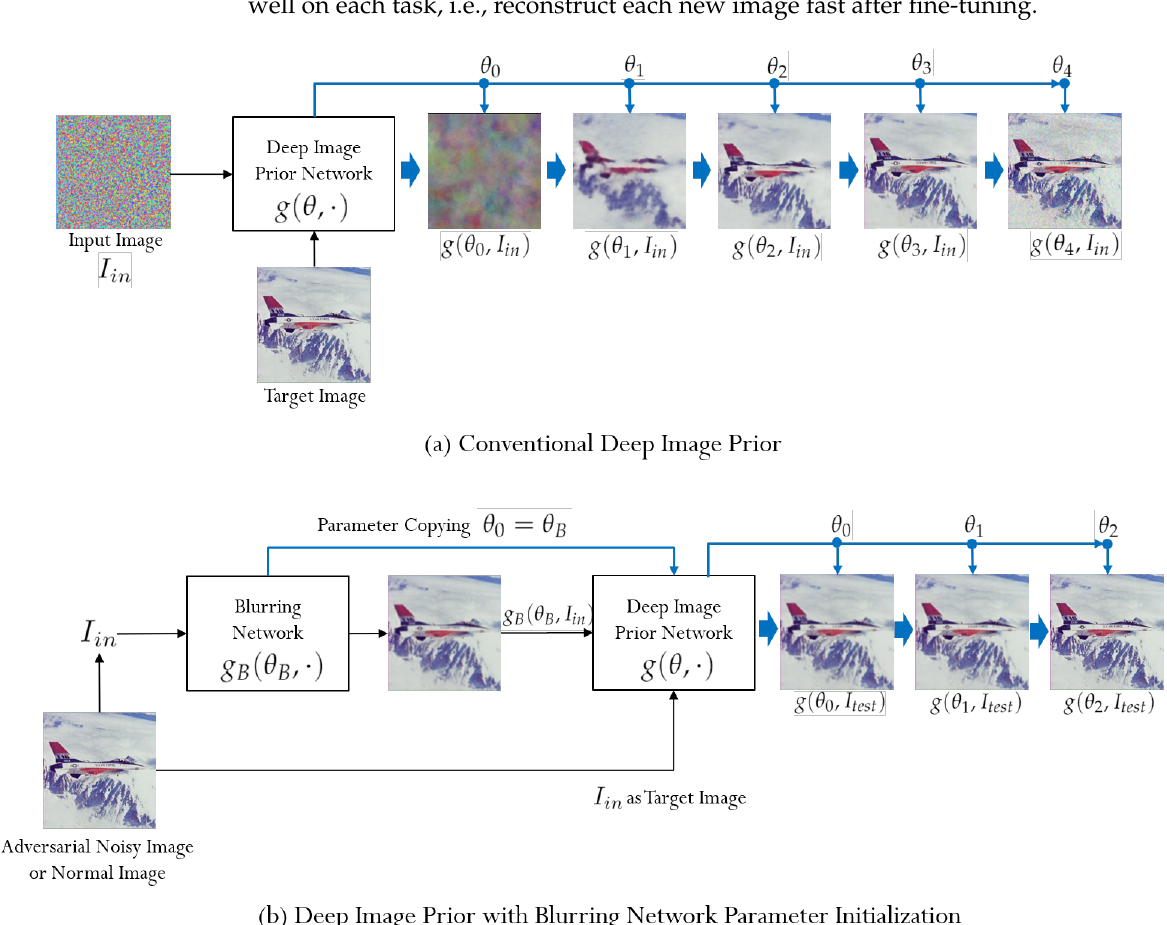
Figure 2. Initialization of Deep Image Prior (DIP) with blurring network parameters for fast convergence. ( a ) Conventional DIP of slow convergence ( b ) DIP initialized with blurring network